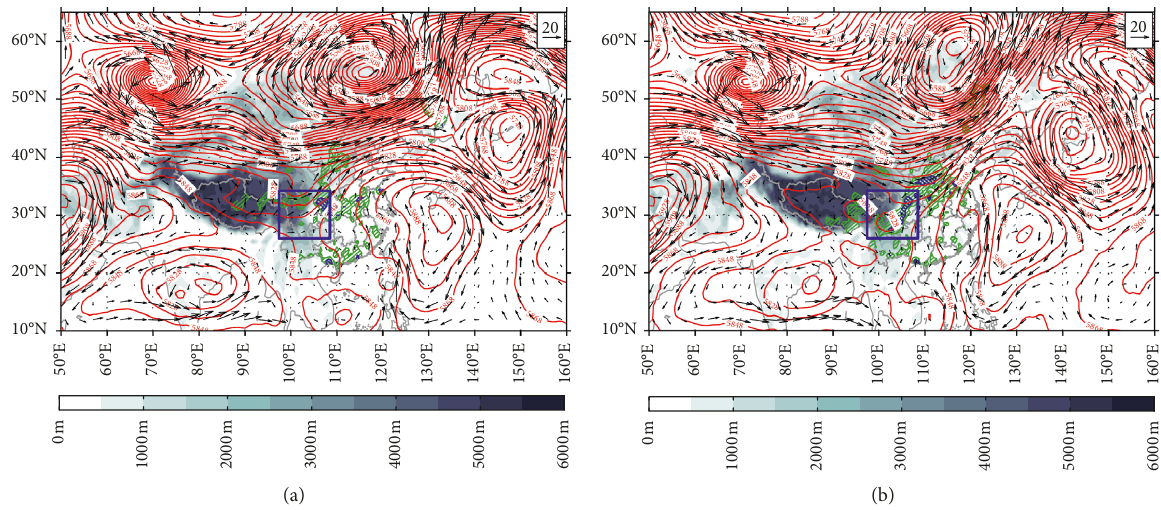
Figure 3: Averaged 500hPa geopotential heights (GPHs) (red contours; unit: gpm) and wind (black vectors; unit: m/s) from ERA-Interim reanalysis data and gauge-based precipitation data (green contours for 10 mm and blue contours for 50mm) for 24 h period: (a) 1200 UTC GPHs are averaged. The shaded areas show the terrain elevations (shaded every 1000m) in eastern